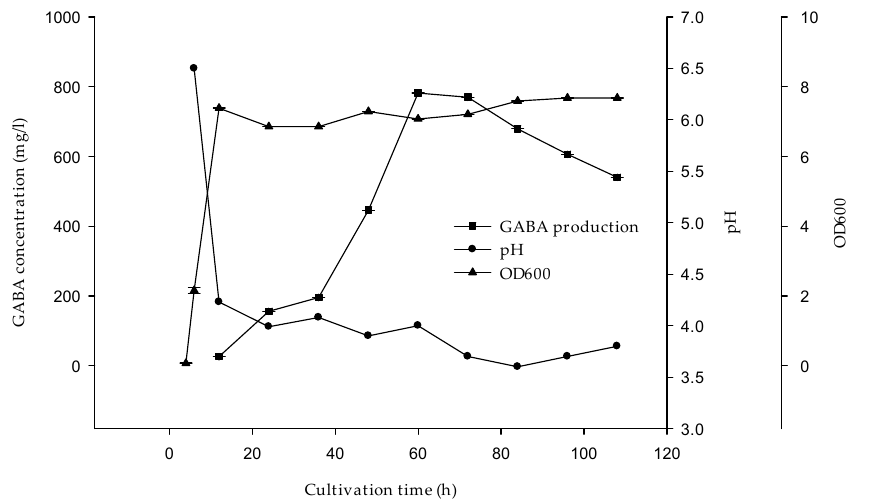
Figure 2. Time course of γ -aminobutyric acid (GABA) production, bacterial growth, and change in pH during cultivation of L. plantarum FNCC 260 strain in MRS broth supplemented with 118 mM MSG at 37 °C. Data shown as mean ±SD with SD less than 5%. The experiments were conducted at least in duplicates.